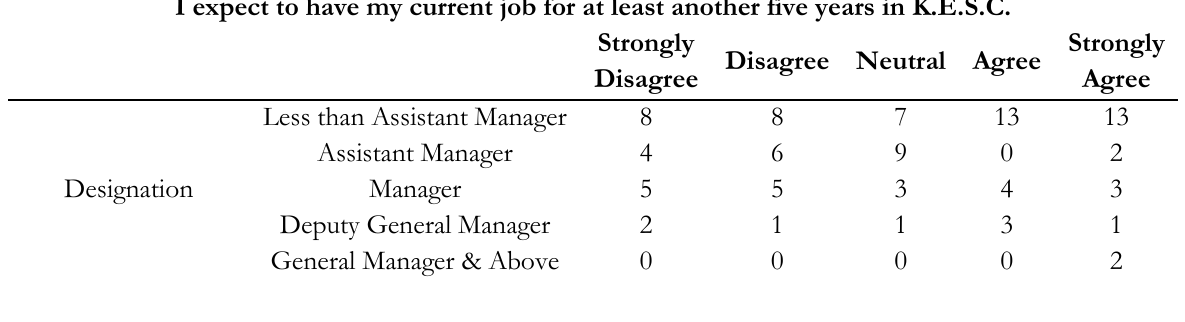
Table 9: DSG * Q16 Cross tabulation I expect to have my current job for at least another five years in